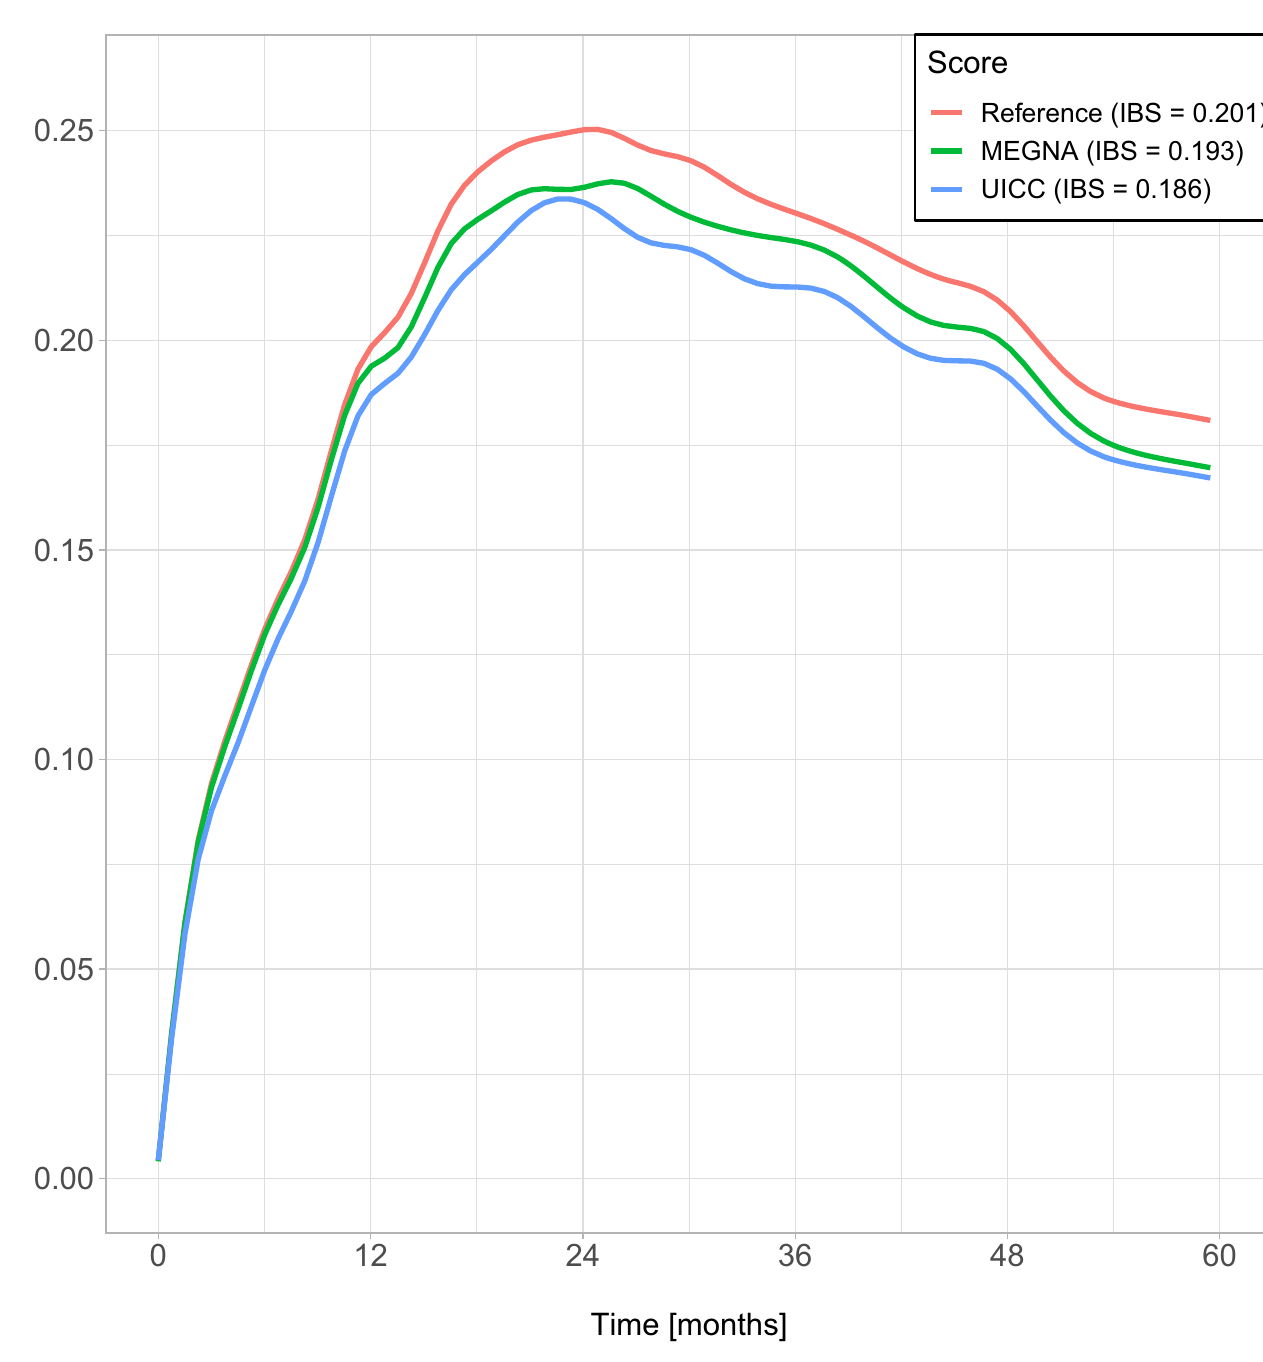
PLOS ONE | https://doi.org/10.1371/journal.pone.0228501 February 3,